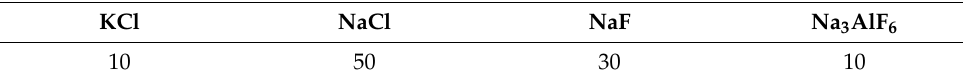
Table 2. The mix of metals for the sublayer (wt.%). Metal Sb Cu Fe As Zn Sn Pb